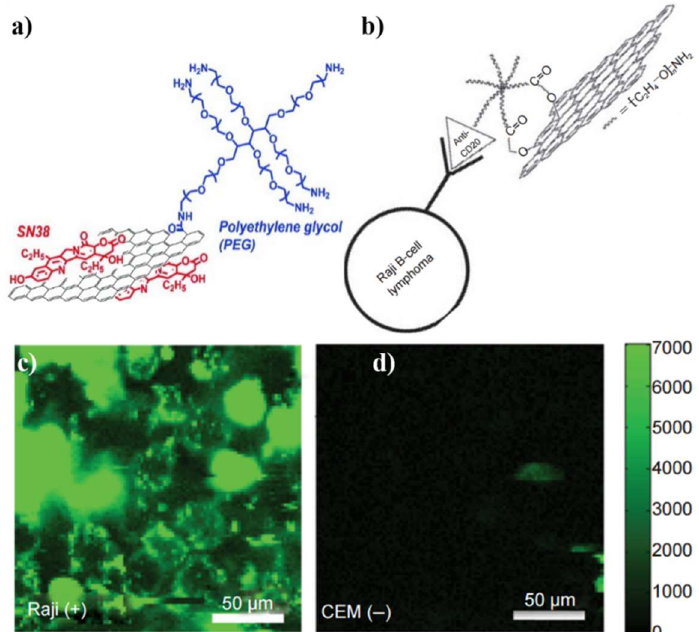
Figure 8. Schematic illustration of ( a ) PEG-NGO; ( b ) the selective binding and cellular imaging of PEG-NGO conjugated with anti-CD20 antibody, Rituxan; NIR fluorescence image of CD20 positive Raji B-cells ( c ) and CD20 negative CEM T-Cells ( d ) treated with the NGO PEG Rituxan conjugate. The scale bar shows the intensity of total NIR emissions (in the range 1100–2200 nm). Images are false-colored green. Reproduced from [43] (a), with permission from American Chemical Society, 2008. Reproduced from [153] (b–d), with permission from Springer Nature, 2008.